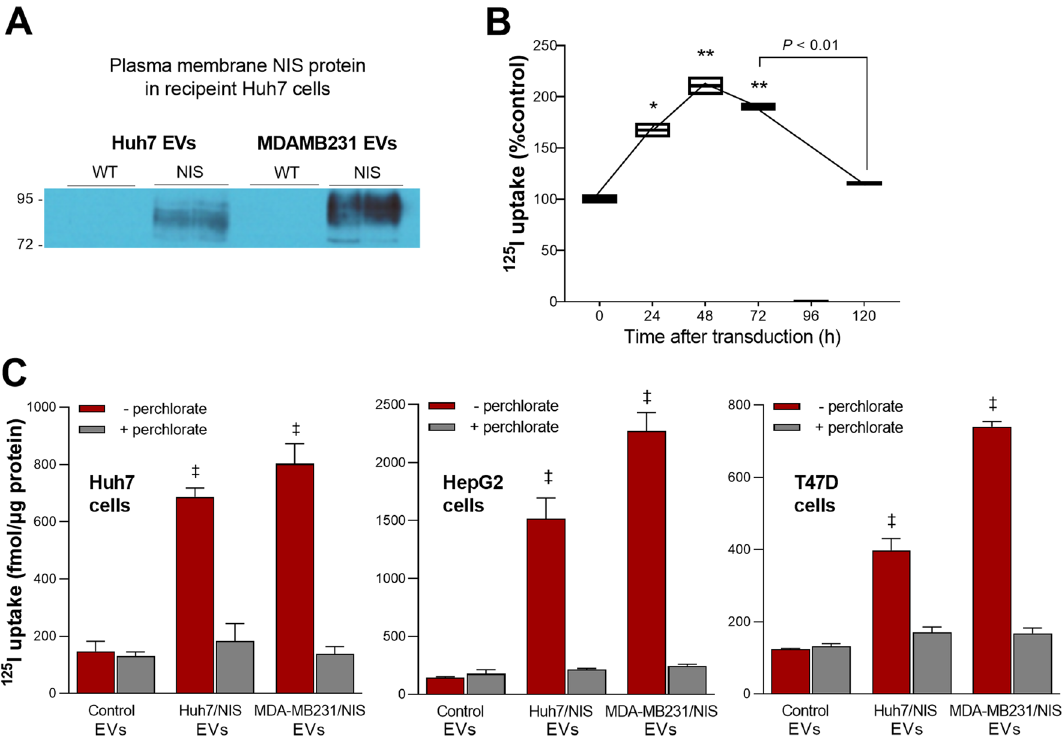
Figure 4. NIS protein and 125 I uptake in cancer cells treated with EVs. ( A ) Western blots of NIS protein obtained from the plasma membrane fractions of recipient Huh7 liver cancer cells treated with EVs derived from Huh7/NIS-Adv and MDAMB/NIS-stable donor cells (n = 2 per group). ( B ) Time dependence of 125 I uptake in recipient Huh7 cells treated with EVs s derived from Huh7/NIS-Adv cells. ( C ) 125 I uptake in recipient Huh7 and HepG2 human liver cancer cells, and T47D human breast cancer cells in 24-well plates at 48 h after treatment with 25 µg per well of EVs derived from Huh7/NIS-Adv or MDAMB/NIS-stable donor cells. All cell uptake data are the mean ± SD of values from triplicate samples per group with or without perchlorate inhibition. * P < 0.05; ** P < 0.01; ‡ P < 0.0001, compared to controls.